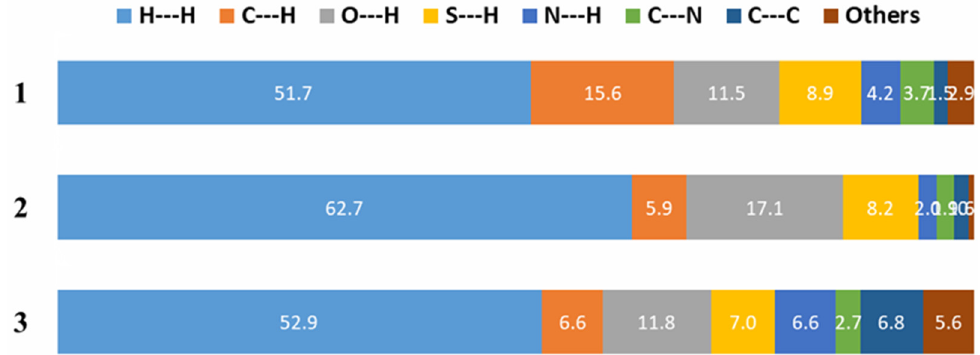
Figure 6. Fingerprint plot for compounds 1 − 3 showing percentages for all interactions and O--H, N-- H and C--H contacts in the total Hirshfeld surface area.